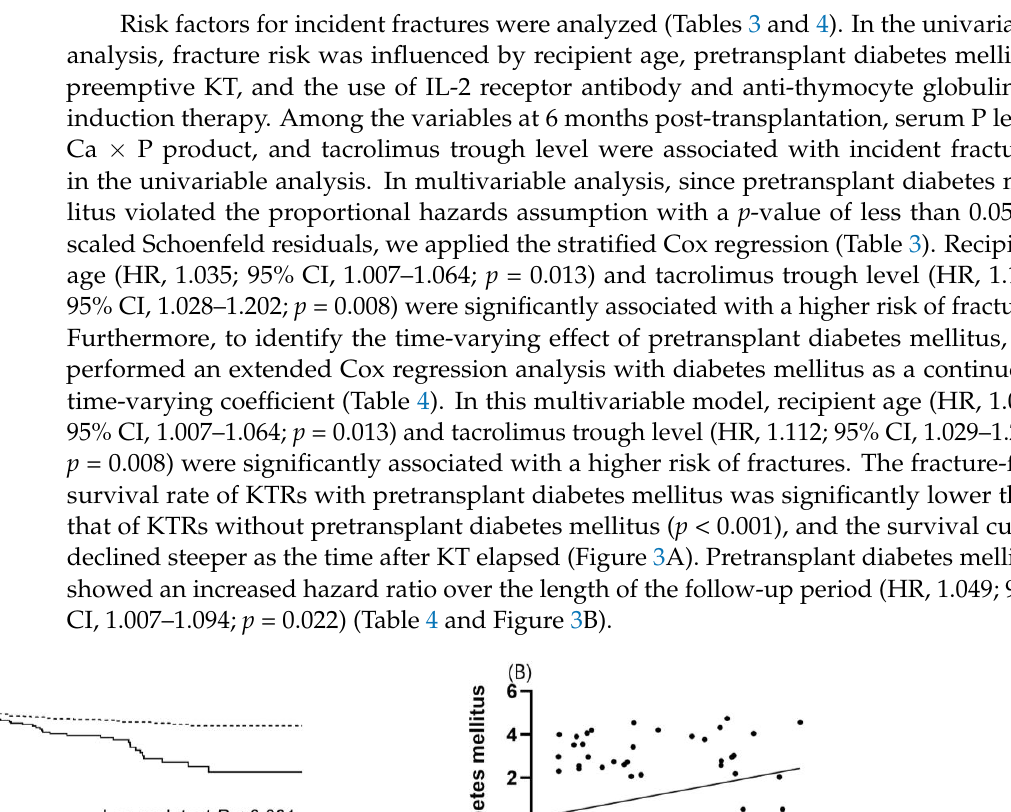
Figure 2. Location of the incident fractures.